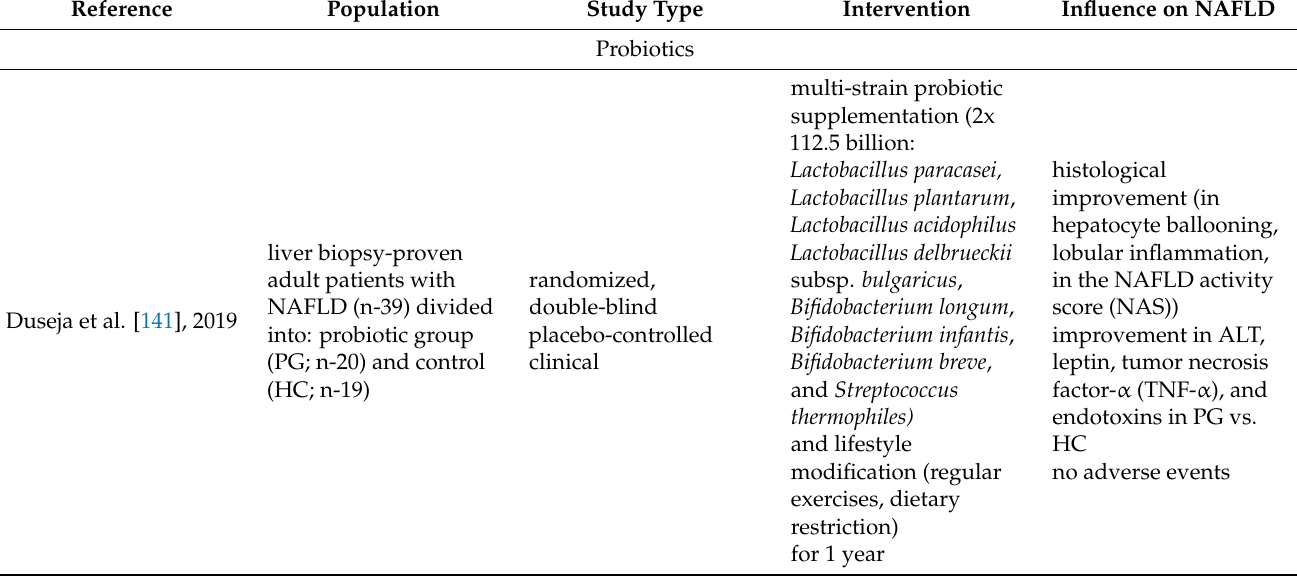
Table 2. Summary of the recent clinical studies concerning probiotics, prebiotics, or symbiotics in NAFLD.